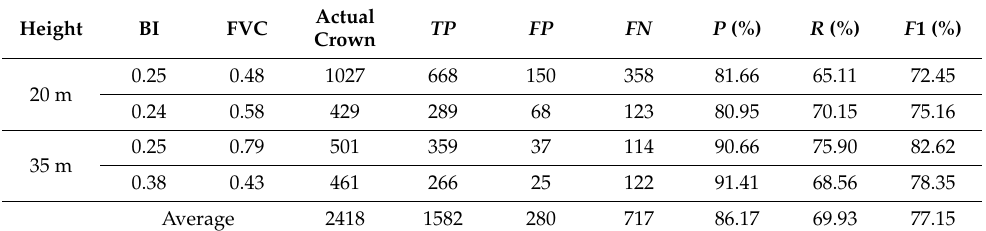
Table 7. Statistical table of crown recognition (color vector + LBP).